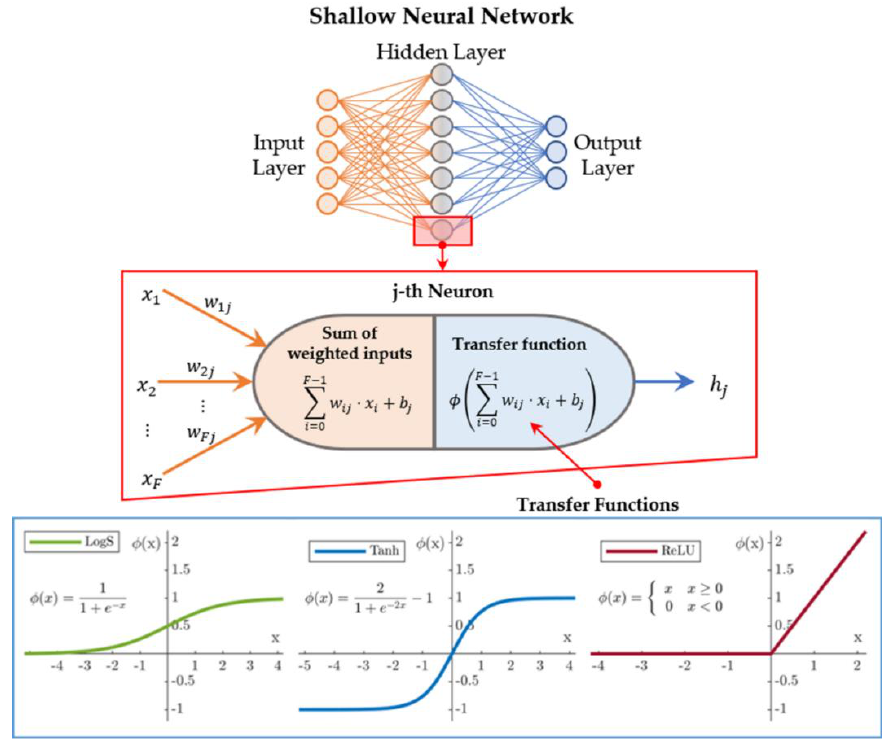
Figure 3. The SNN topology, the artificial neuron unit, and the main used transfer functions. Artificial neurons perform the network computations: these are logistic regression models with a nonlinear activation function. This means that each neuron in the first hidden layer implements a dot product between the input feature vector x ∈ R F and the vector ( 1 ) ∈ R F that represents the weights of the connections it has made with each w j